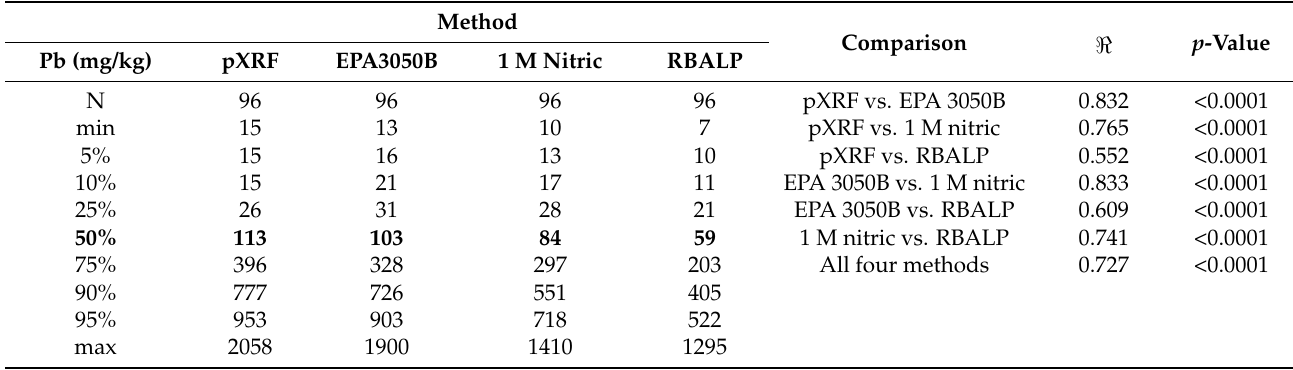
Table 1. Percentiles and Universal (cid:60) agreement coefficients with p -values for the 4 soil Pb analysis methods compared in this study. Medians are given as bold